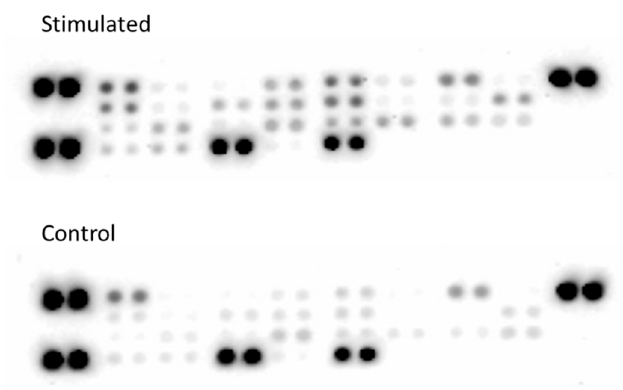
Figure 4. Cytokine array membrane. Protein profiling in cell culture supernate in stimulated and control condition. Overnight stimulation of glial-rich culture with 1 µ M CGRP causes differential expression of cytokines compared to control condition. Table 1. Average fold change in the level of cytokines release in glial rich cell culture after exposure to CGRP compared to control condition.